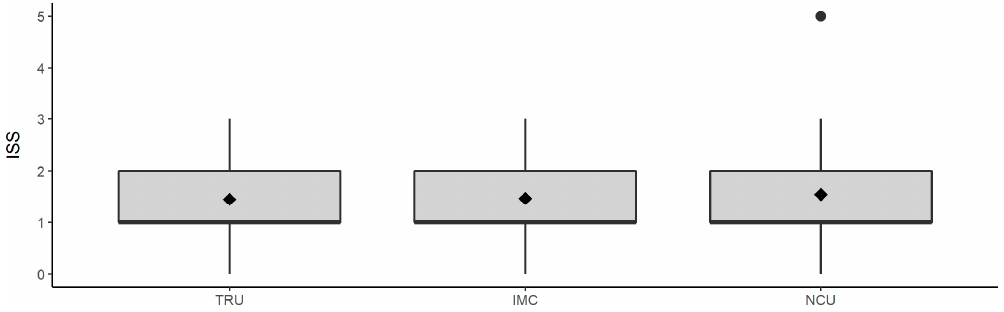
Figure 1. Distribution of ISS in each unit (TRU, IMC, NCU). Rhombuses represent the arithmetic mean. Medians are located at the bottom of the boxes (ISS = 1). The dot indicates outliers. TRU = Trauma Resuscitation Unit; IMC = Intermediate Care Unit; NCU = Normal Care